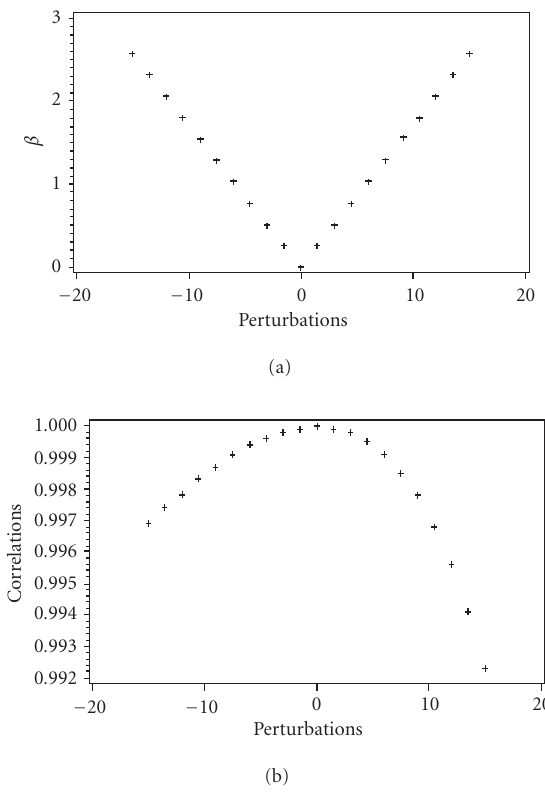
Figure 3. (a) Univariable synthesis method—e ff ect of perturb- ing s 1 on partial regression coe ffi cients. The x -axis represents the perturbation; the y -axis represents the change in the regression coe ffi cient in standardized distance between the perturbed and unperturbed models. (b) Univariable synthesis method—e ff ect of perturbing s 1 on correlations. The x -axis represents the per- turbation; the y -axis represents the correlation between the pre- dicted values for the perturbed and unperturbed